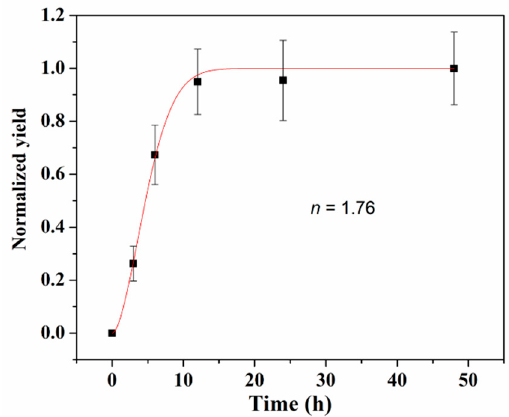
5 of 11 Table 1. Summary of the kinetic fitting to the sample synthesis.